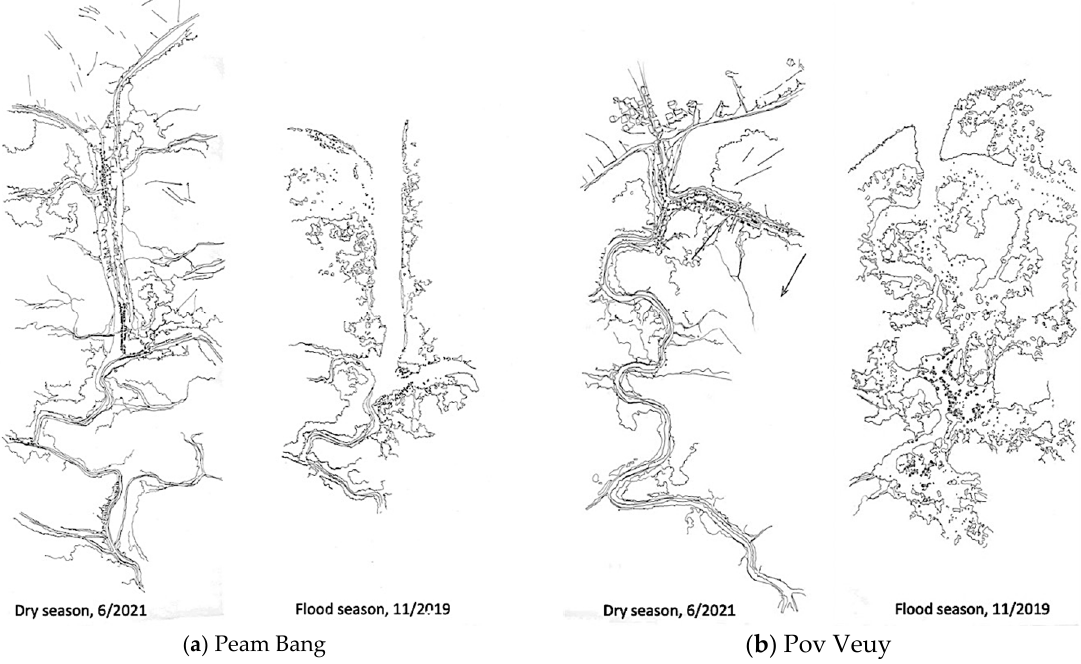
Figure 4. Transforming configurations of prei and phum . In Peam Bang and Pov Veuy, there is an impermanence of landscape and settlement morphologies as determined by the flood − pulse regime.